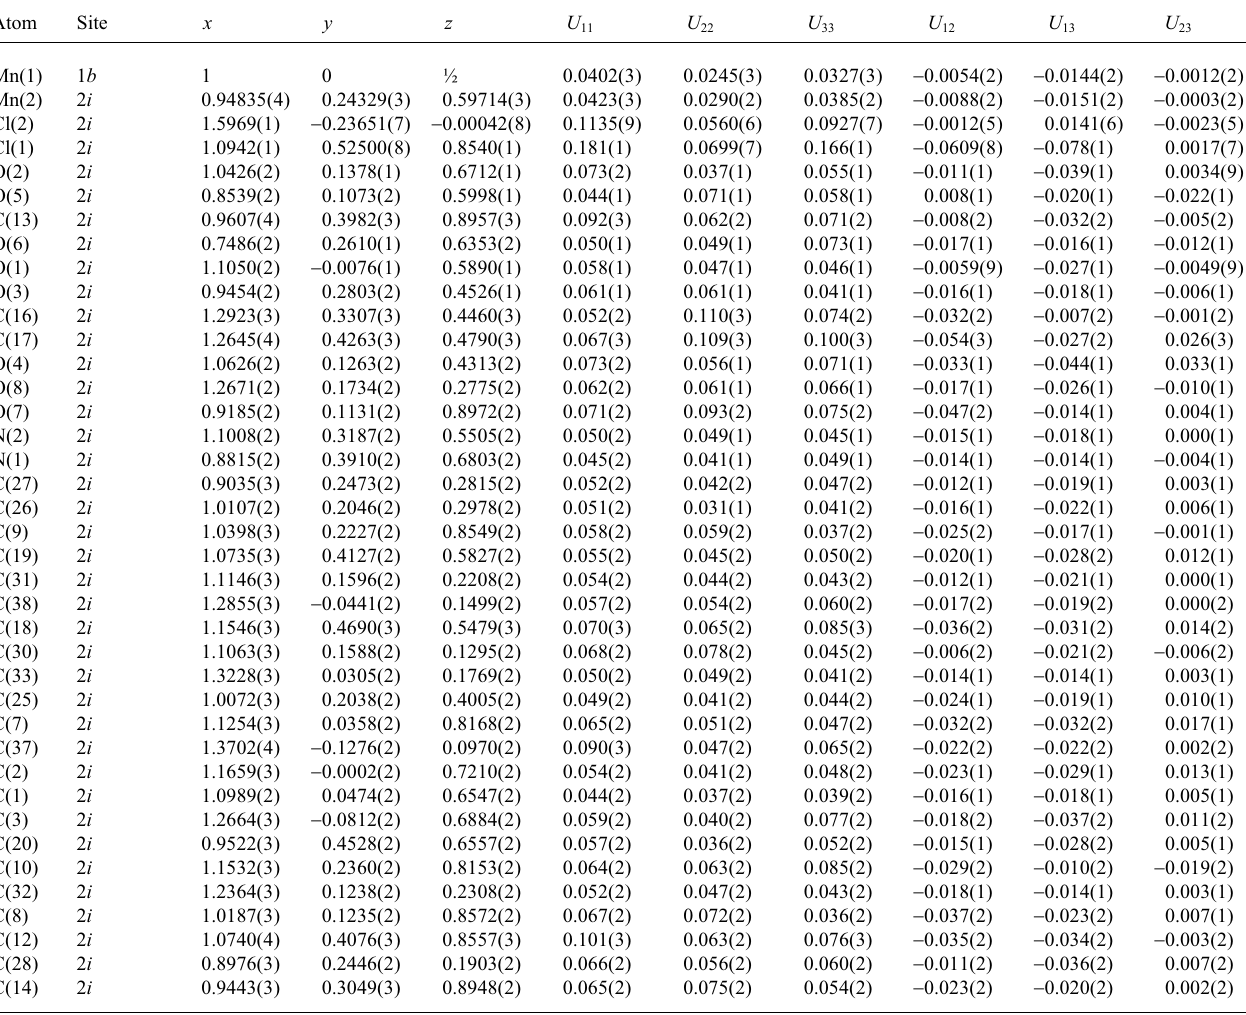
Table 3. Atomic coordinates and displacement parameters (in Å 2 ).